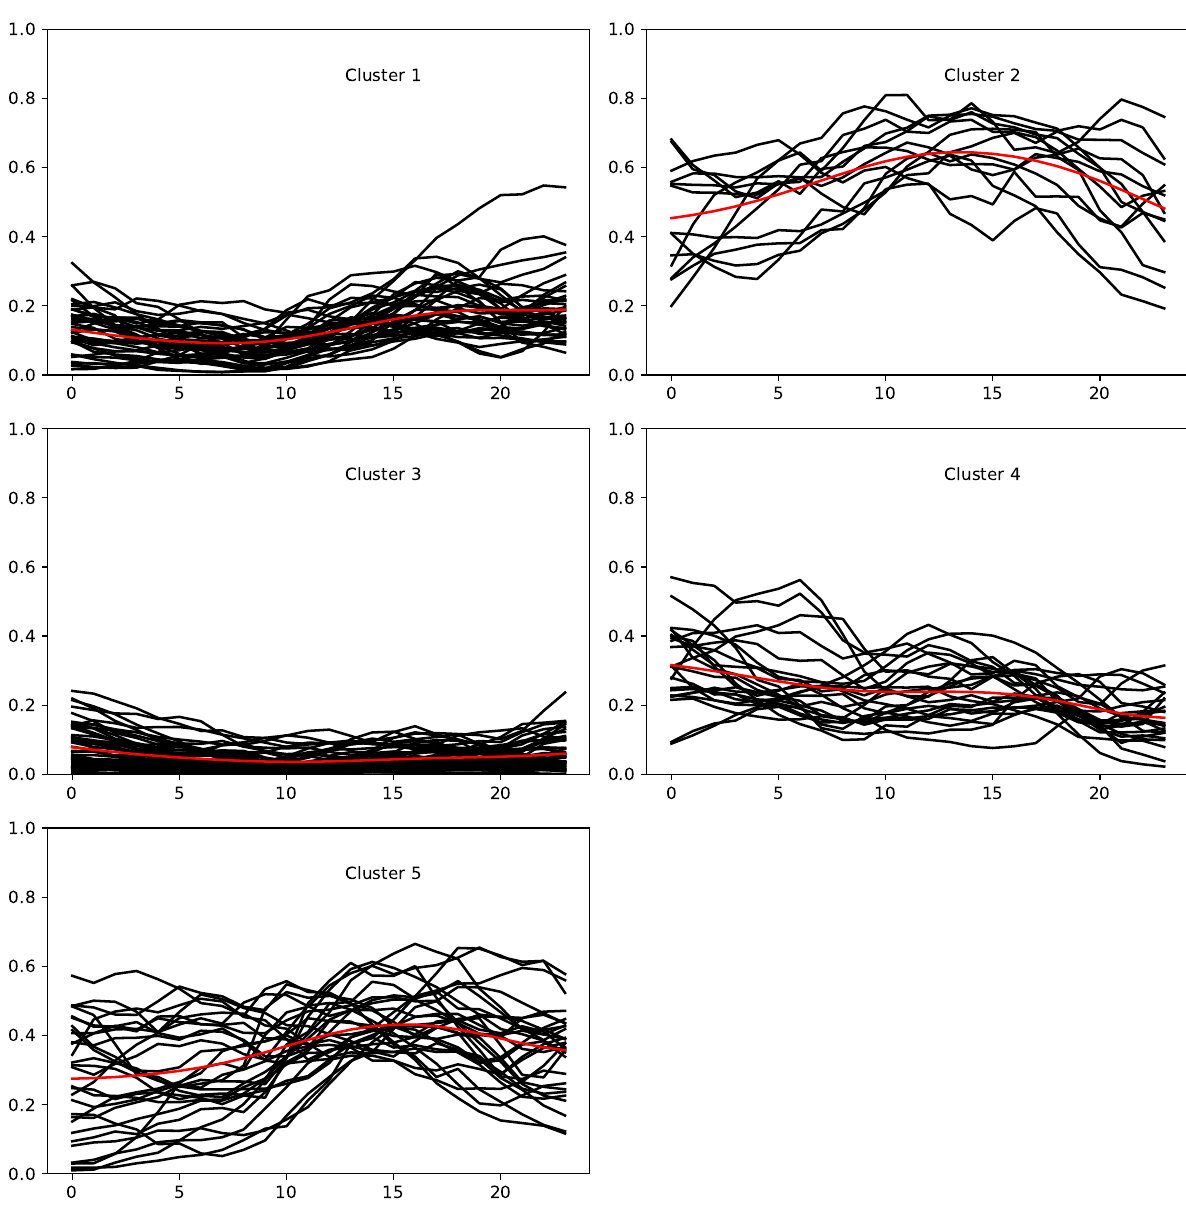
Figure A5. Season 2 wind generation data